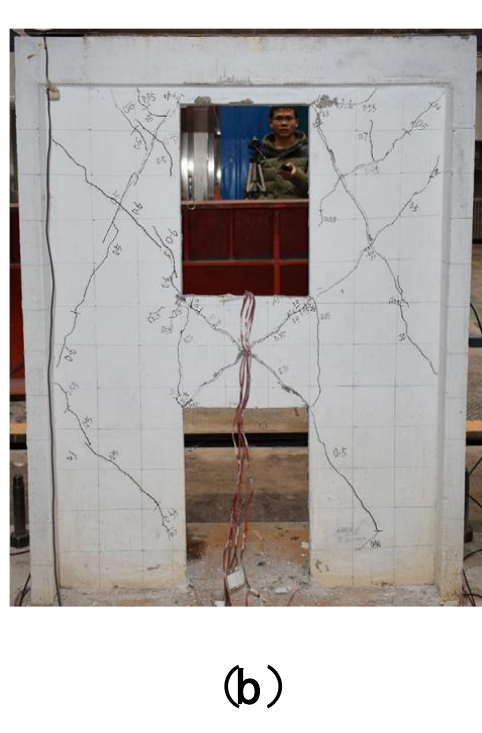
Figure 4. ( a ) crack diagram; ( b ) failure mode of A1 [19].